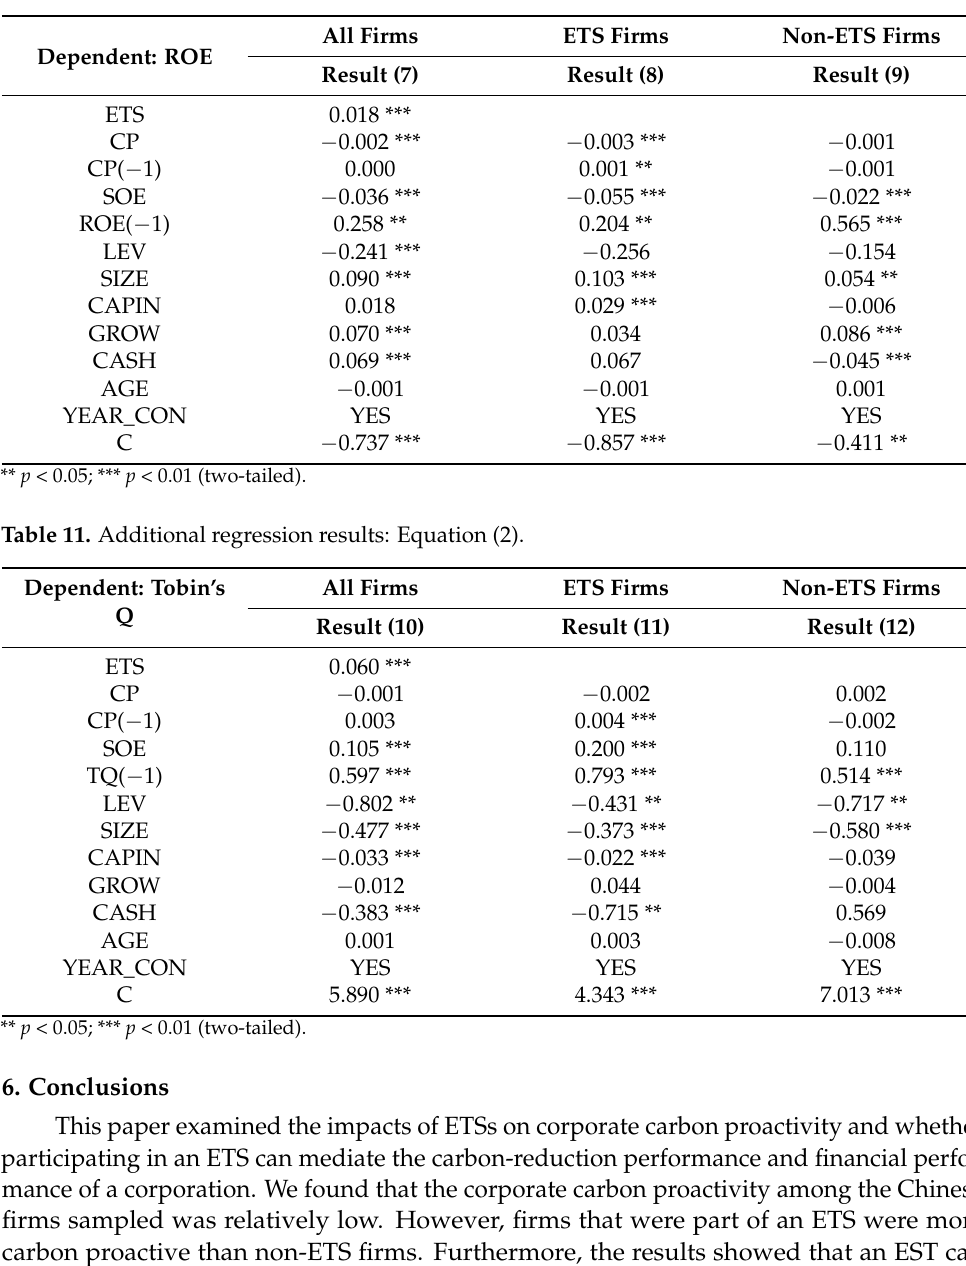
Table 10. Additional regression results: Equation (2).